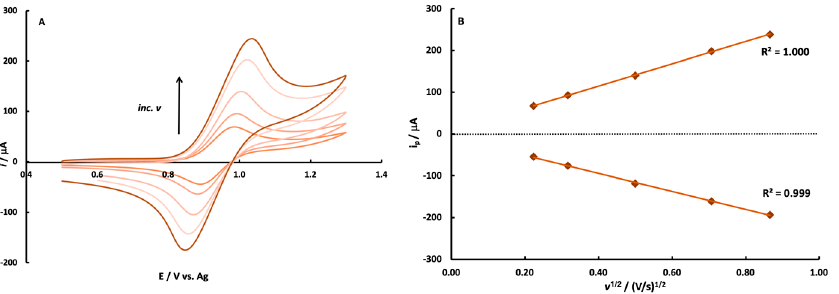
Figure 2. Cyclic voltammograms ( A ) and peak current versus the square root of scan rate ( B ) for a solution containing 5.0 mM Ru(bpy) 3 2+ in 0.10 M PBS (pH 7.4). Scan rates investigated were 0.05, 0.10, 0.25, 0.50, and 0.75 V/s.